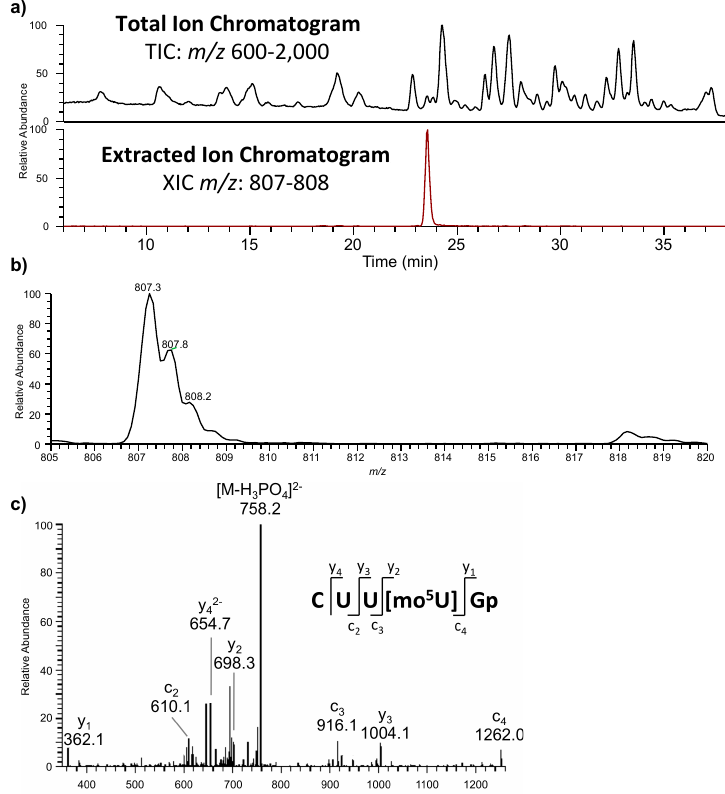
Figure 5. Representative example of RNA modification mapping by LC ‐ MS/MS. ( a ) Total ion chromatogram (TIC) and extracted ion chromatogram (XIC) for RNase T1 digest of Lactococcus lactis . Only one peak for the XIC of m / z 807 is detected; ( b ) This doubly ‐ charged m / z value is consistent with a digestion product of composition (U 3 CGp + 30). Two known modified nucleosides have a mass change of 30 Da: 5 ‐ methoxyuridine (mo 5 U) and 5 ‐ methyl ‐ 2 ‐ thiouridine (m 5 s 2 U). As only the former was found in the nucleoside digest, mo 5 U is most likely the modified nucleoside in this digestion product; ( c ) Tandem mass spectrometry (MS/MS) data confirming sequence as CUU[mo 5 U]Gp, which maps onto Ala ‐ tRNA UGC . Figure adapted from [58] with permission.